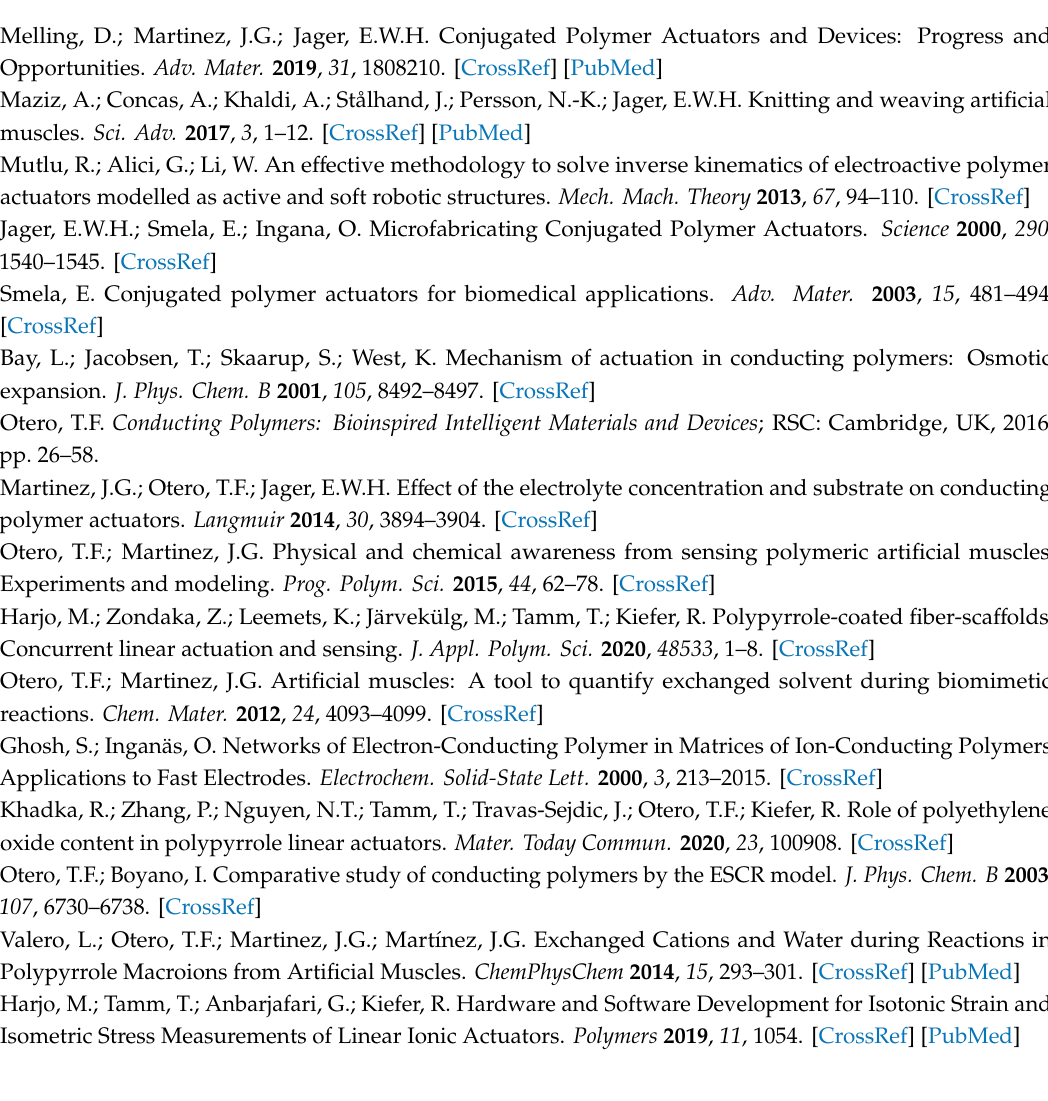
Figure 5. Chronopotentiometric responses to square current density waves for PPy-PEO/DBS (±0.085 A g − 1 , ±0.17 A g − 1 , ±0.34 A g − 1 , ±0.85 A g − 1 , ±1.7 A g − 1 and ±3.4 A g − 1 ) and PPy/DBS (±0.12 A g − 1 , ±0.24 A Figure S1: Cyclic voltammetry (scan rate 5 mV s − 1 ) in potential range 0.65 to − 0.6 V against Ag / AgCl (3 M KCl) of PPy films operating in aqueous electrolytes of LiCF 3 SO 3 (black line), NaCl (red line), EDMICF 3 SO 3 (green line) and TMACl (blue line) showing the charge density Q against potential E of a: PPy-PEO / DBS and b: PPy / DBS films, Figure S2: Chronoamperometry of PPy / DBS linear films at varied current densities ( ± 0.12 A g − 1 , ± 0.24 A g − 1 , ± 0.48 A g − 1 , ± 1.2 A g − 1 , ± 2.4 A g − 1 and ± 4.8 A g − 1 ) and frequencies (0.0025 Hz, 0.005 Hz, 0.01 Hz, 0.025 Hz, 0.05 Hz and 0.1 Hz) in di ff erent aqueous electrolytes LiCF 3 SO 3 ( (cid:4) ), NaCl ( • ), EDMICF 3 SO 3 ( showing in a : the electrical Energy U e , in b : the potential E red at reduction and in c : the linear strain ε against the current density j at